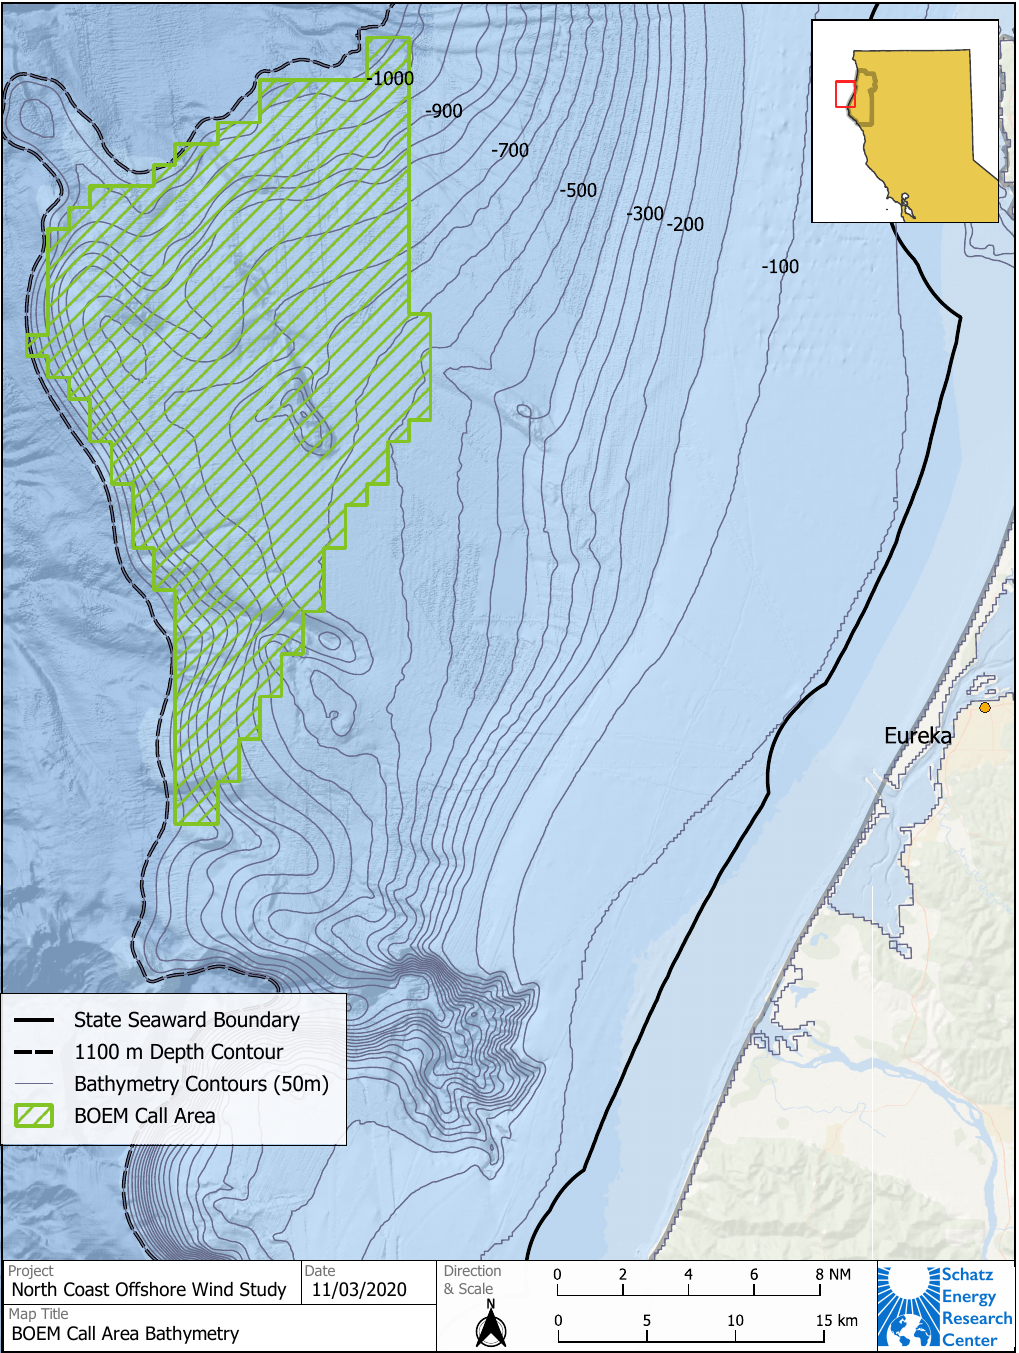
Figure A1. Northern California Call Area with 50 m bathymetric